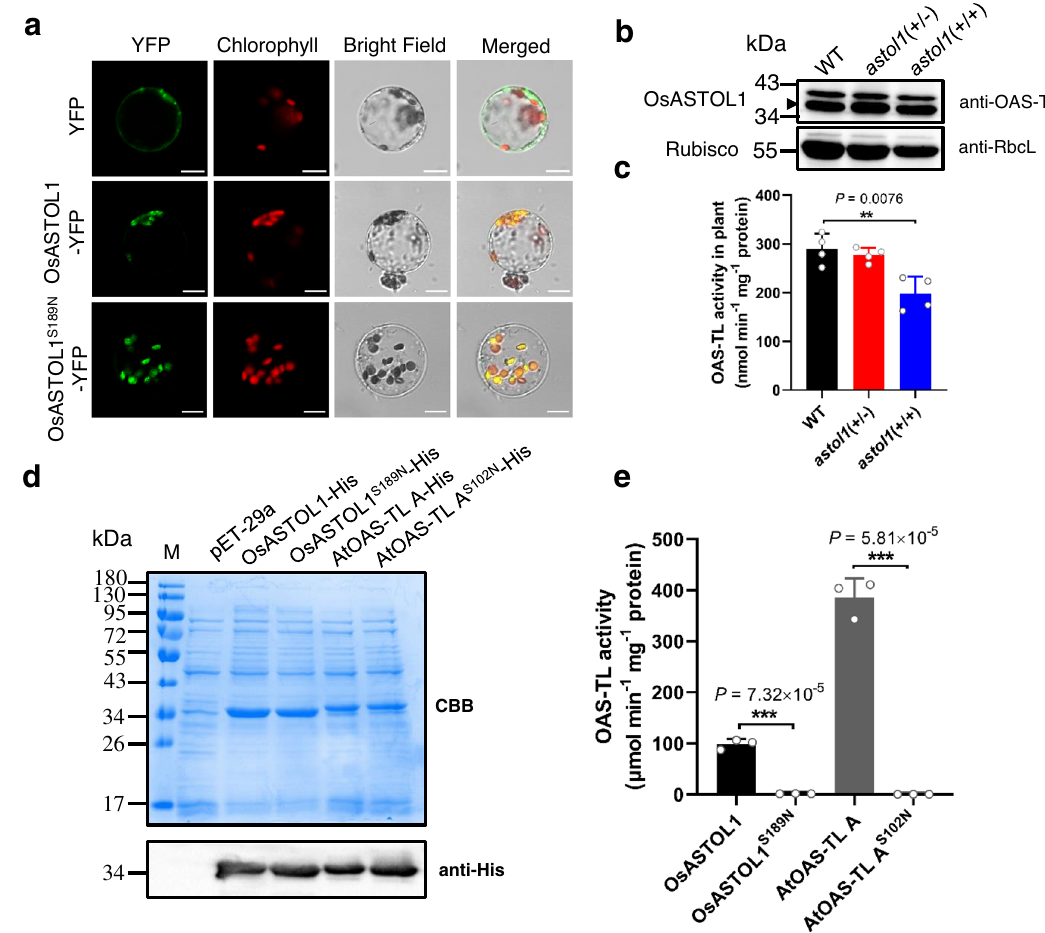
Fig. 2 OsASTOL1 encodes a chloroplast-localized O -acetylserine(thiol)lyase (OAS-TL). a Subcellular localization of OsASTOL1. Rice protoplasts were expressed with the eYFP (top), OsASTOL1-eYFP (middle), or Osastol1-eYFP (bottom) driven by the cauli fl ower mosaic virus 35S promoter. Left to right: YFP fl uorescence, chlorophyll auto fl uorescence, bright- fi eld images, and merged images. Scale bars, 10 µ m. At least fi ve protoplasts were investigated with similar results to the images shown in a . b Validation of OsASTOL1/ OsASTOL1 S189N protein (lower band) levels in 3-week-old WT, astol1 ( + / − ), and astol1 ( + / + ) using immunoblot analysis. OsASTOL1/ OsASTOL1 S189N protein levels are detected by AtOAS-TL A1 antibody (anti-OAS-TL A) and Rubisco large subunit is used as a loading control. The experiment was repeated two times and similar results were obtained. c Total OAS-TL enzyme activity in whole soluble protein extracts of the shoots of 3-week-old WT, astol1 ( + / − ), and astol1 ( + / + ). Data are shown as means ± s.d., n = 4 biological replicates; each biological replicate represents an individual plant. d Expression of recombinant mature OAS-TL proteins in E. coli . Proteins were separated on SDS-PAGE and visualized by Coomassie Brilliant Blue (CBB) staining (upper) and by immunoblot with anti-His antibody (bottom). M, marker. The experiment was repeated two times and similar results were obtained. e In vitro OAS-TL enzyme activity of puri fi ed mature OsASTOL1 and AtOAS-TL A and their corresponding mutant proteins. Data are shown as means ± s.d., n = 3 technical replicates. WT, wild type. astol1 ( + / − ), astol1 heterozygote. astol1 ( + / + ), astol1 homozygote. Asterisks in c , e indicate signi fi cant difference by two-sided Student ’ s t test: ** P < 0.01, *** P <